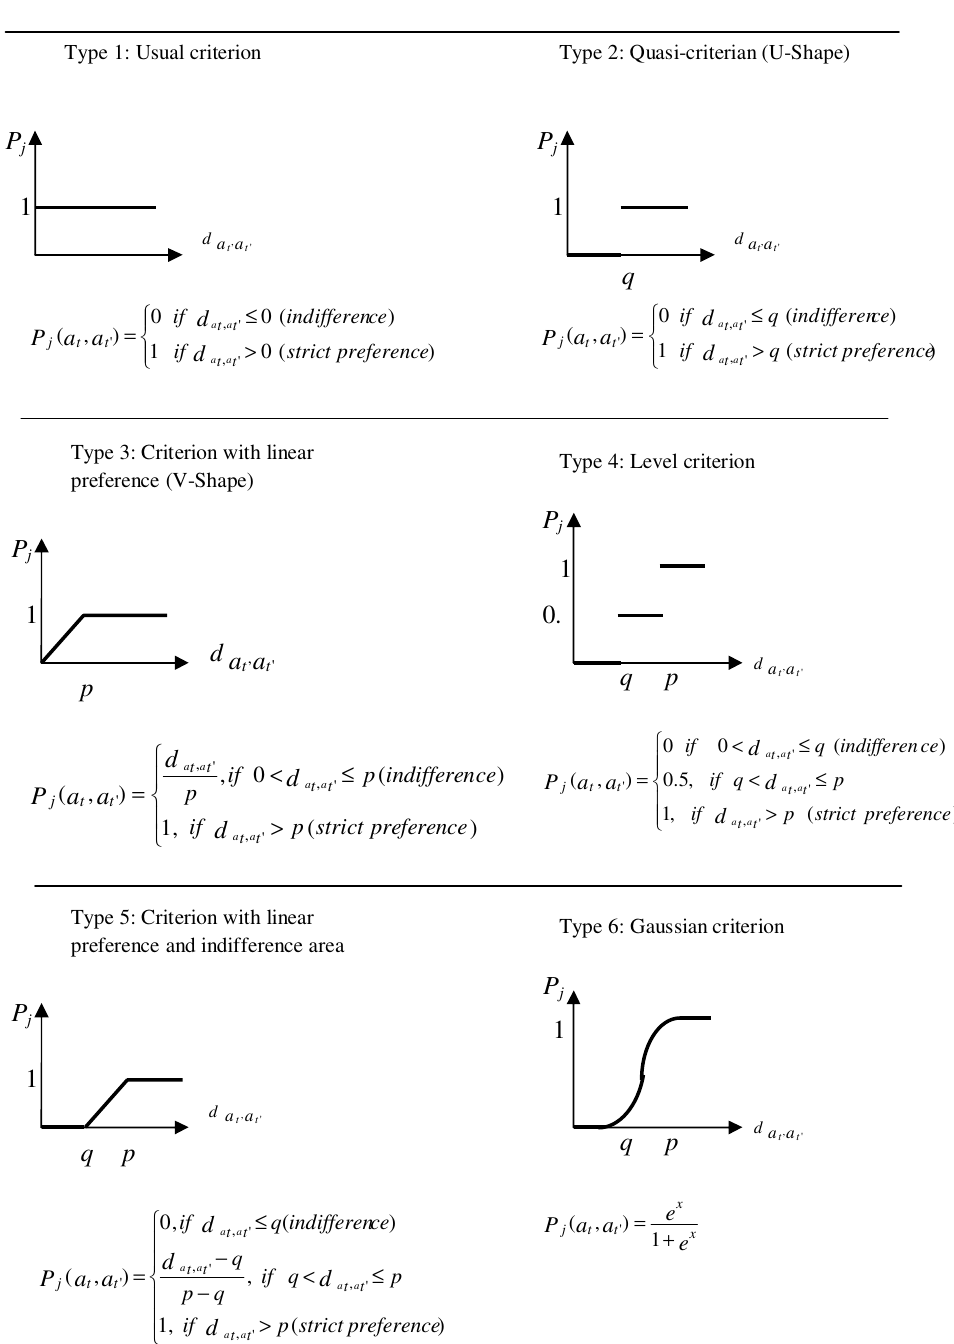
Figure 1. PROMETHEE generalized preference functions [39; 43;